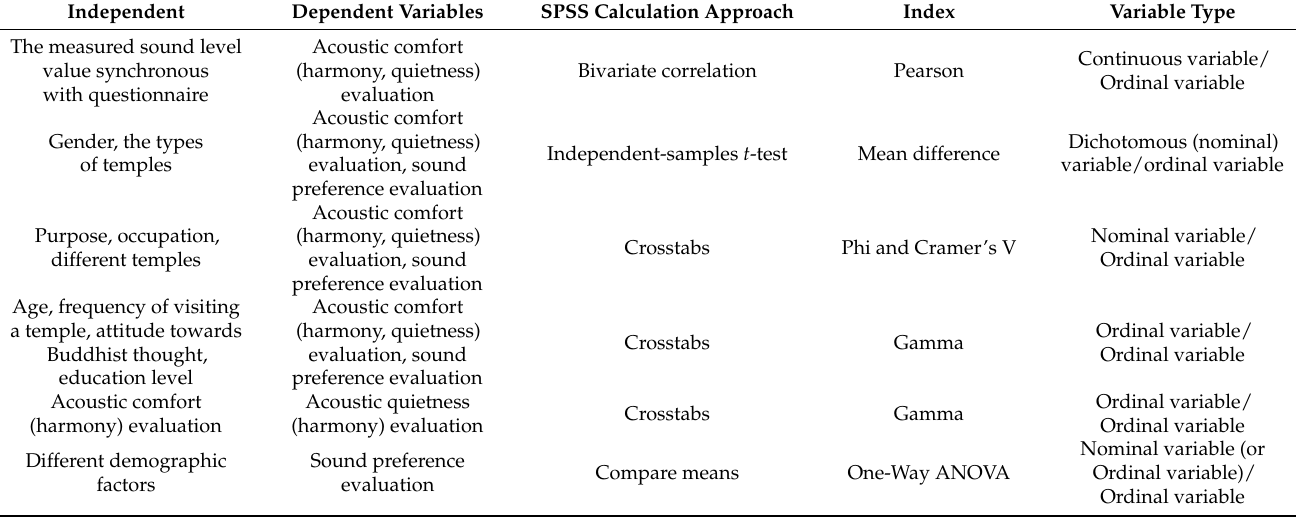
Table 1. The calculation method for independent and dependent